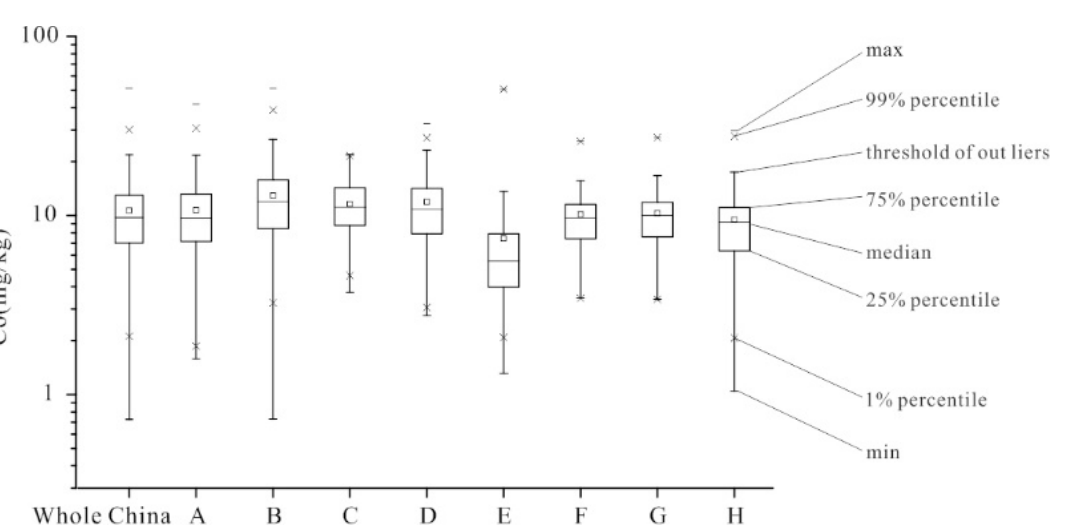
Figure 8. Boxplots showing the Co ( μ g/kg) abundance of 1:200,000 map sheet grids in different tectonic units of China (for summary statistics, refer to Table 3). Notation: (A)